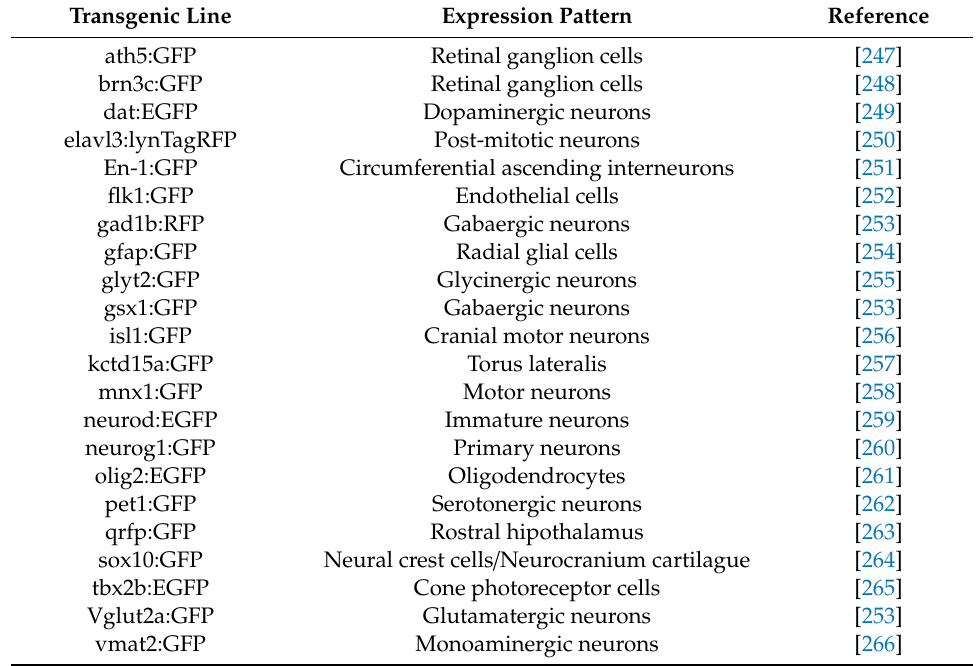
Table 8. Examples of developed zebrafish transgenic